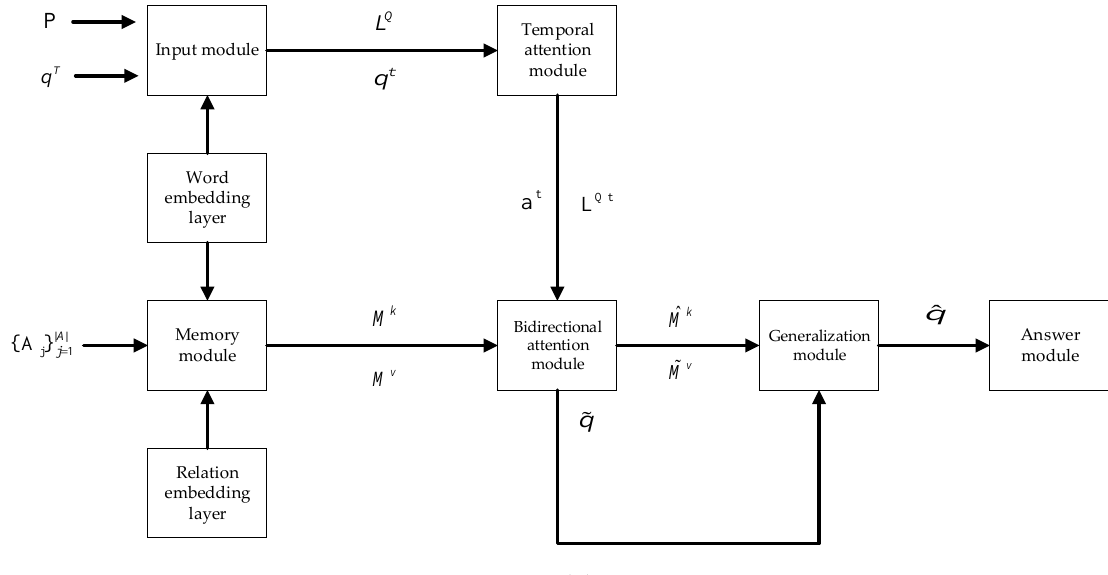
Figure 1. Model overview.